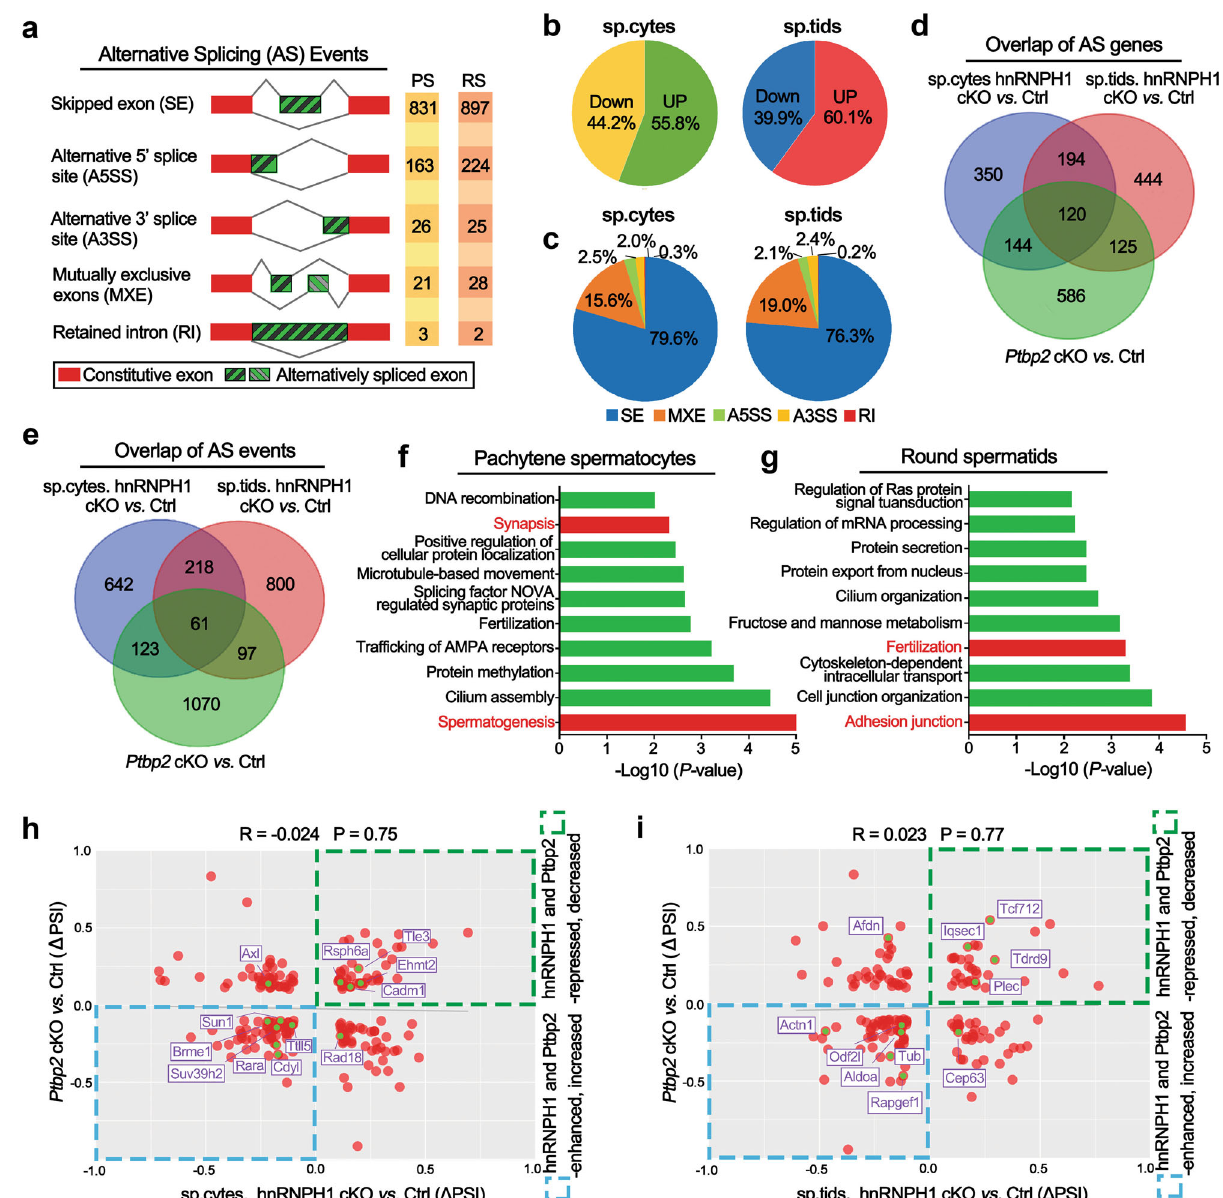
Fig. 4 hnRNPH1 and PTBP2 synergistically regulate pre-mRNA splicing in spermatogenic cells. a Summary of differential splicing analysis performed using pachytene spermatocytes (PS) and round spermatids (RS) isolated from the control and hnRNPH1 cKO testes at P25. The numbers of predicted alternative splicing (AS) events in each category upon hnRNPH1 deletion are indicated. b Pie charts showing percentages of changed AS events identi fi ed in hnRNPH1 cKO versus control spermatocytes (left) and spermatids (right). c Pie charts representing the distribution of regulated splicing events among different splicing patterns in hnRNPH1 cKO versus control spermatocytes (left) and spermatids (right). d Venn diagrams showing overlap of abnormal AS genes (808) in hnRNPH1 cKO spermatocytes, abnormal AS genes (883) in hnRNPH1 cKO spermatids, and abnormal AS genes (975) in Ptbp2 cKO testis. e Venn diagrams show an overlap of abnormal AS events (1044) in hnRNPH1 cKO spermatocytes, abnormal AS events (1176) in hnRNPH1 cKO spermatids, and abnormal AS events (1351) in Ptbp2 cKO testis. f , g GO term enrichment analyses of genes with the same abnormal AS events caused by hnRNPH1- and PTBP2-ablation in spermatocytes ( f ) and spermatids ( g ). The top ten biological processes ranked by log 10 ( p value) are listed. h , i Distribution of Δ PSI values for genes with abnormal AS events in hnRNPH1 cKO spermatocytes ( h ) and spermatids ( i ). The genes involved in indicated signaling pathways and co-regulated by hnRNPH1 and PTBP2 are marked in genome-wide reprogramming of splicing was affected upon Fig. S7a), and the Δ PSI values showed a highly positive hnRNPH1 deletion during this transition process. By analyzing correlation ( R = 0.68, P = 2.2 e − 16 ) (Supplementary Fig. S7b). Remarkably, we found that both the protein and mRNA levels of RNA-seq data, we found that a number of alternative splicing hnRNPH1 progressively declined from pachytene spermatocytes genes or events related to developmental regulation during to round spermatids during spermatogenesis (Supplementary Fig. meiotic spermatocytes to post-meiotic round spermatids transi- S7c, d). Together, these data suggest that hnRNPH1 may be tion overlapped with those susceptible to hnRNPH1 ablation in involved in the genome-wide reprogramming of splicing during pachytene spermatocytes and round spermatids (Supplementary